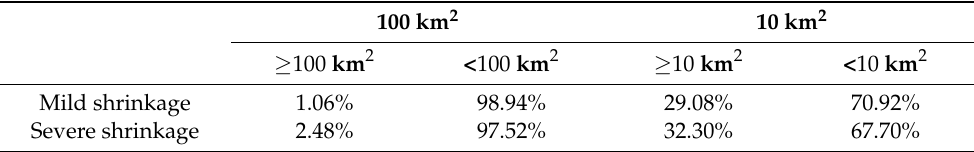
Table 3. Shrinkage ratio of natural cities in the Yellow River affected